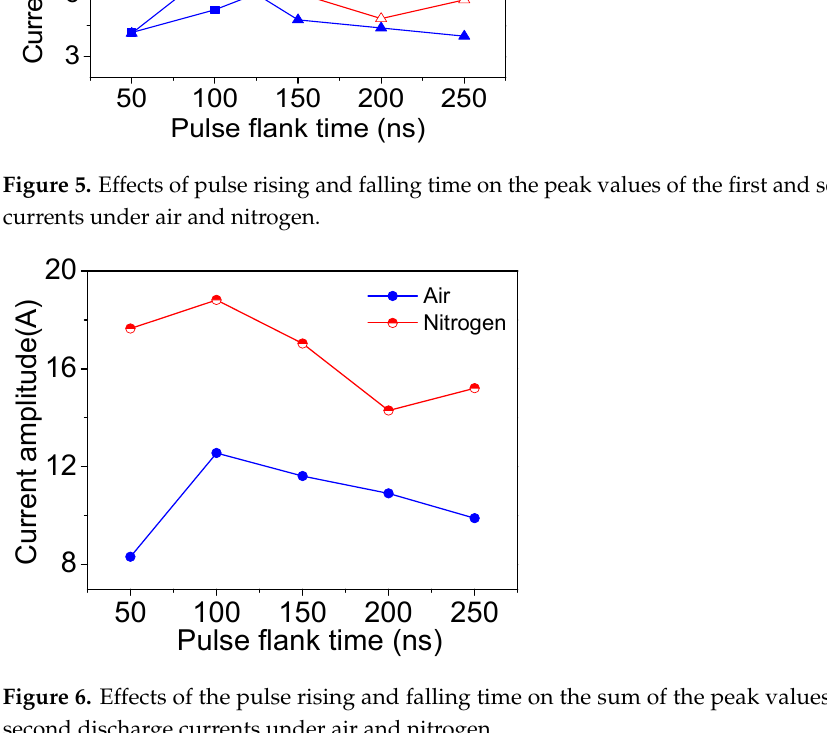
Figure 6. Effects of the pulse rising and falling time on the sum of the peak values of the first and second discharge currents under air and nitrogen.